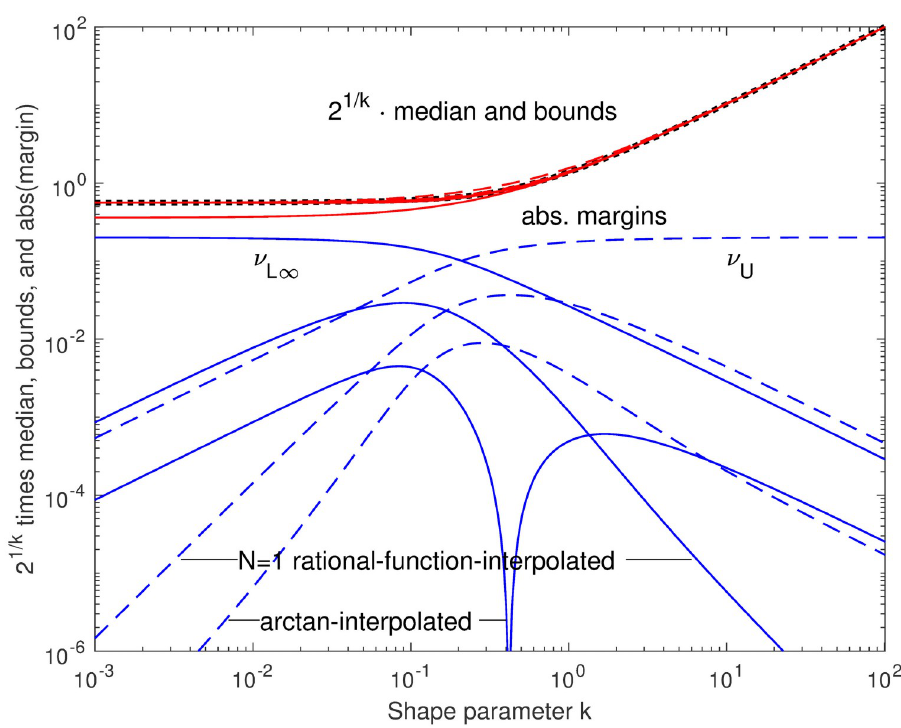
Fig 9. Margins of interpolated bounds, premultiplied by 2 1/ k . The absolute margins of the interpolated bounds are smaller than those of the bounds they started from. Compare Fig 5. The generally smallest margins are for the arctan interpolators, and the intermediate for the N = 1 rational-function